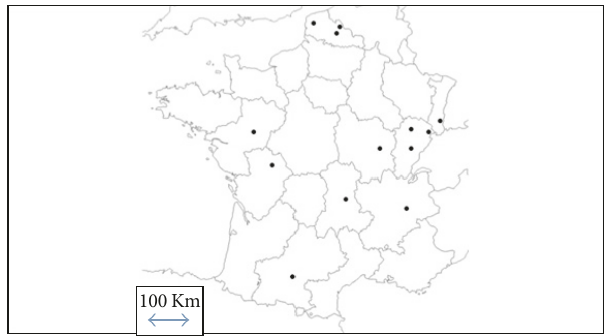
Figure 1: Distribution of participating hospitals in metropolitan France. List of the participating hospitals and local investigators: